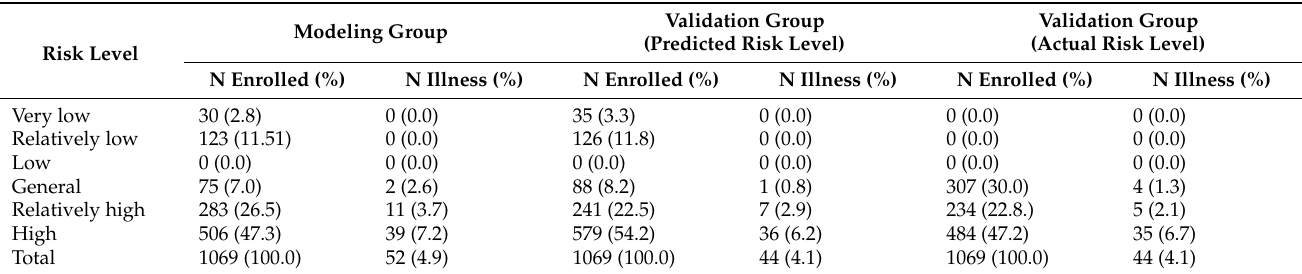
Table 6. The risk levels and the prevalence of the two